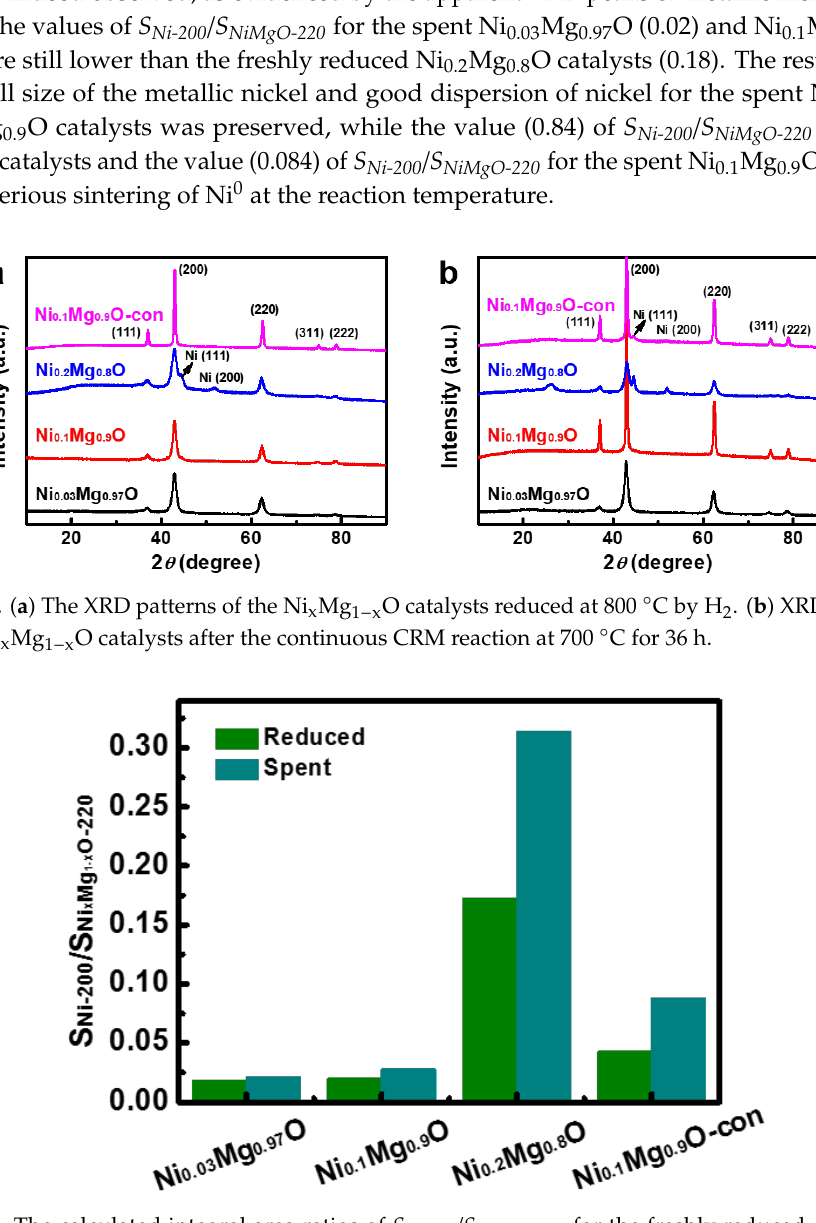
Figure 8. The calculated integral area ratios of S Ni-200 / S NiMgO-220 for the freshly reduced and spent 251 Ni x Mg 1−x O catalysts. 252